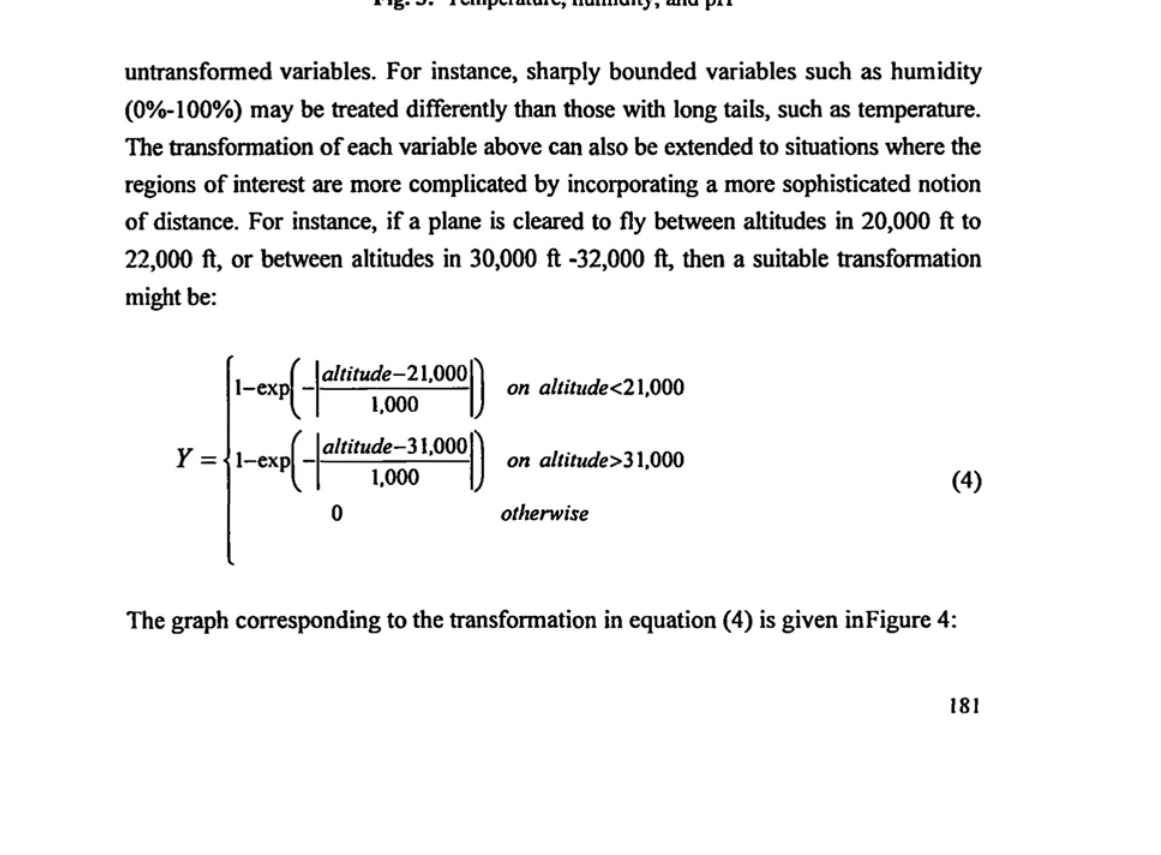
Fig. 3: Temperature, humidity, and